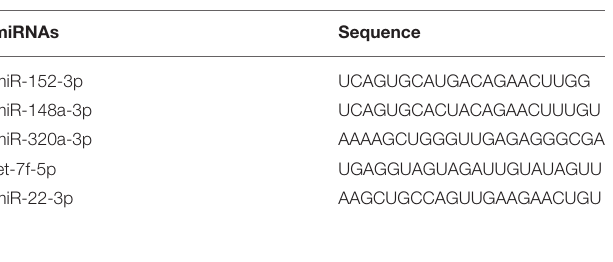
TABLE 4 | Effects of IVM media supplemented with miR-152-3p on the development of parthenogenetic activation porcine embryos. Treatment Total No.